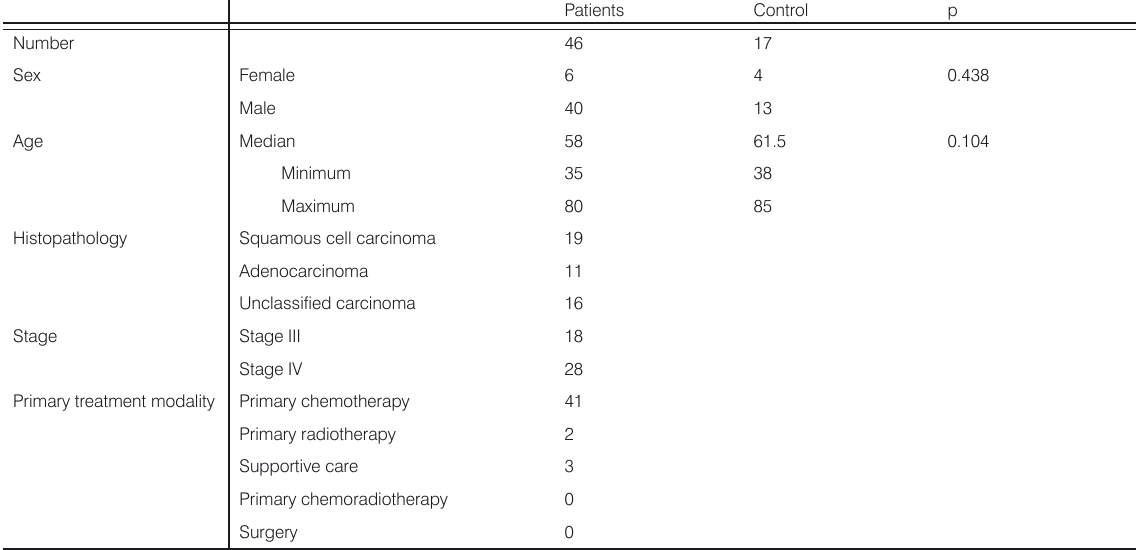
Table 1. Study population characteristics.